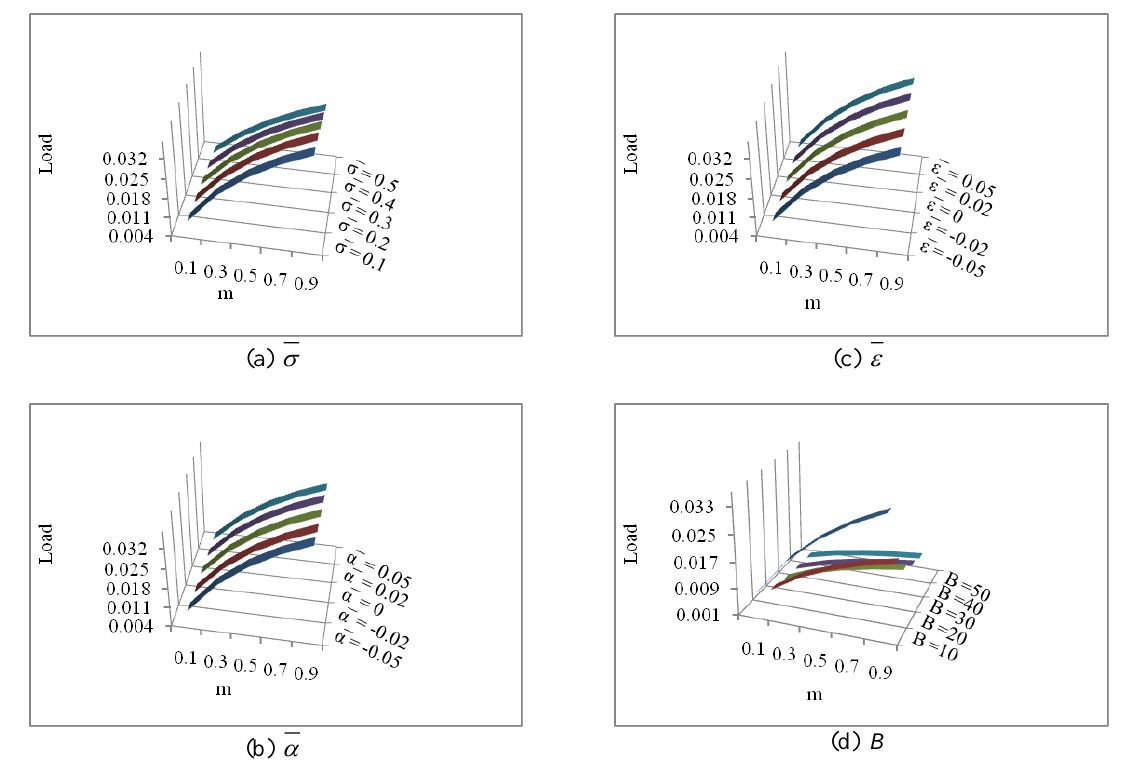
Figure 4. Profile of load bearing capacity with regards to